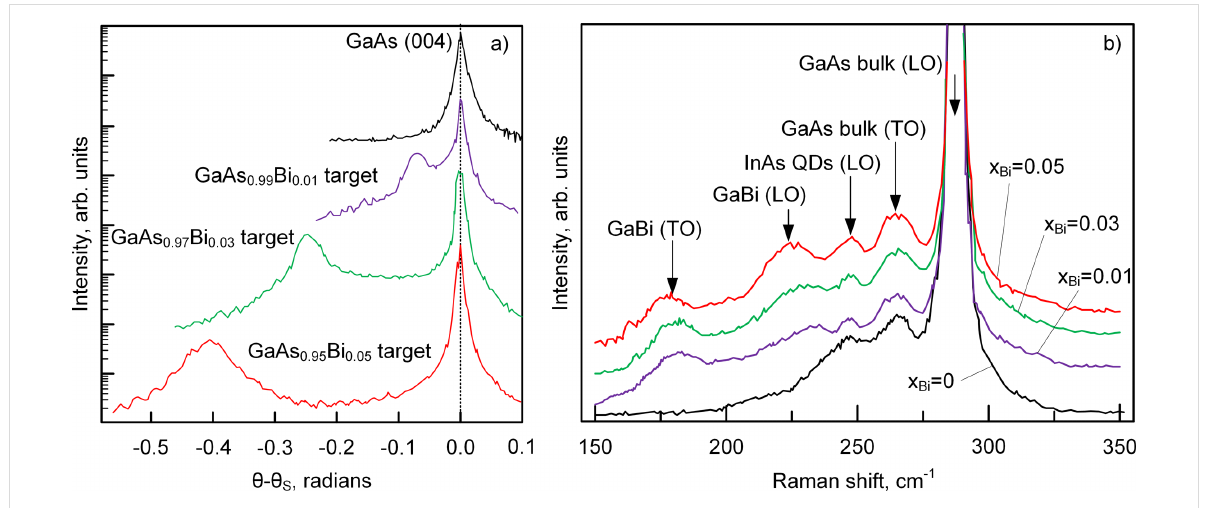
Figure 3: a) XRD spectra of GaAs 1 − x Bi x films grown on GaAs(100) substrates; b) Raman spectra of InAs/GaAs and InAs/GaAs 1 − x Bi x heterostruc- tures.